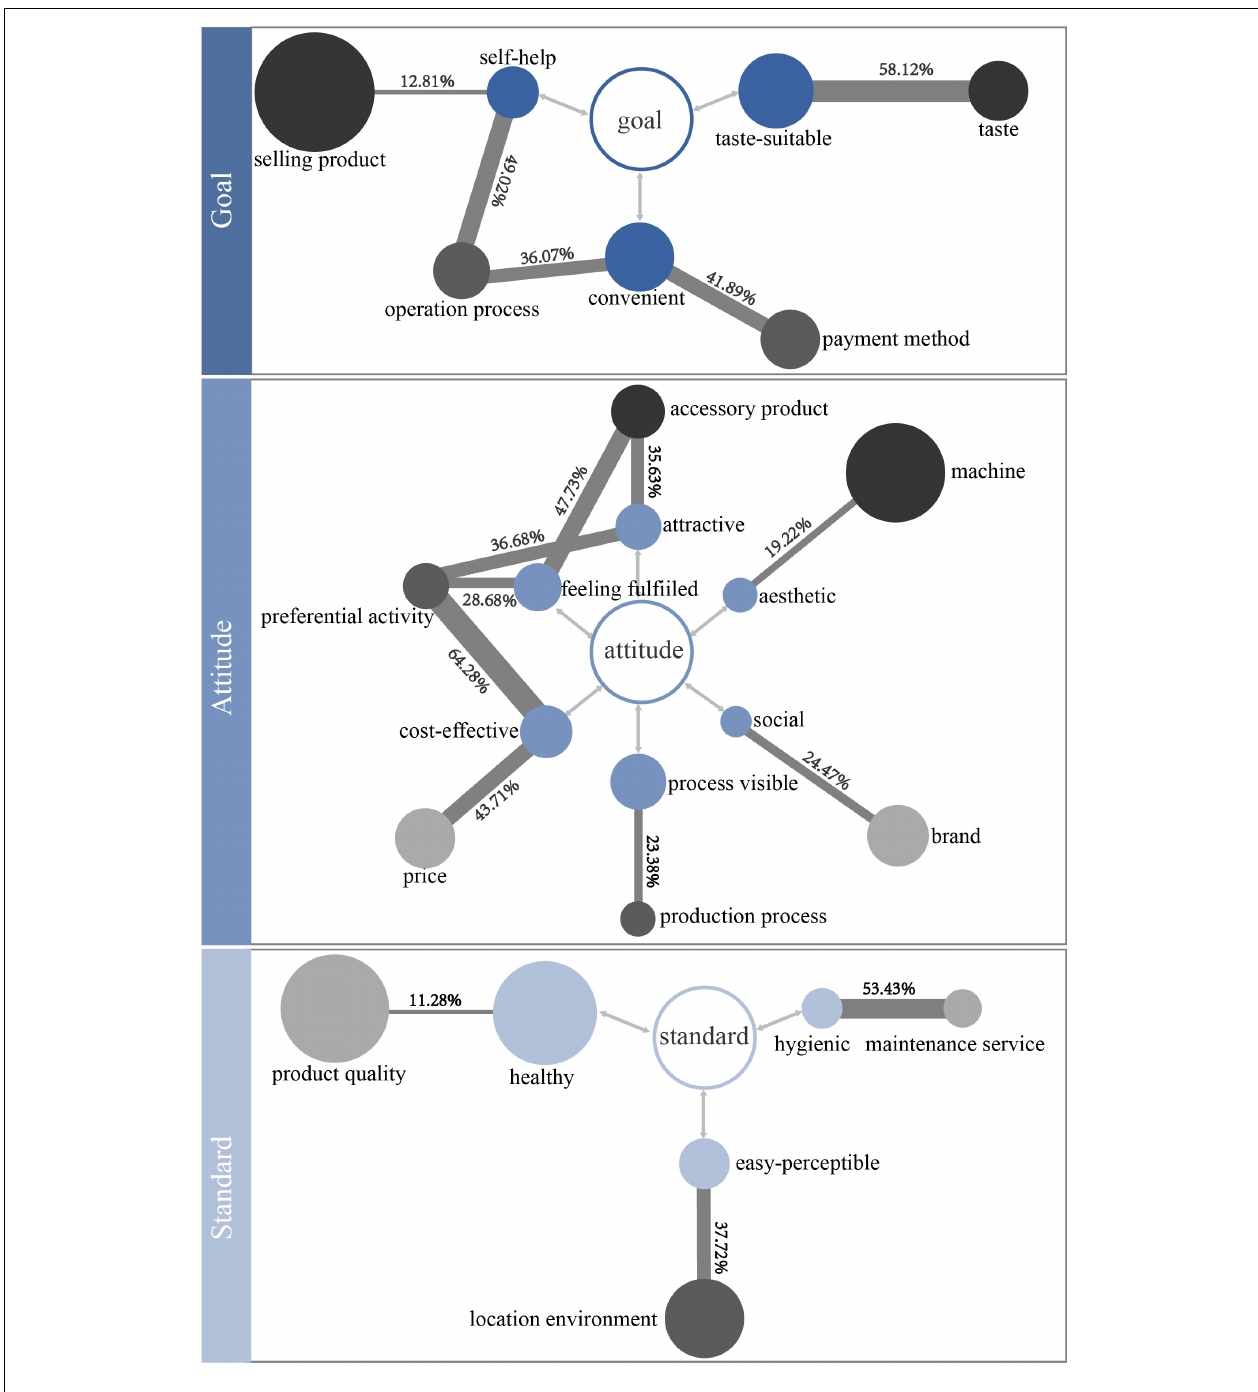
FIGURE 9 | Three types of user concern correlation networks.